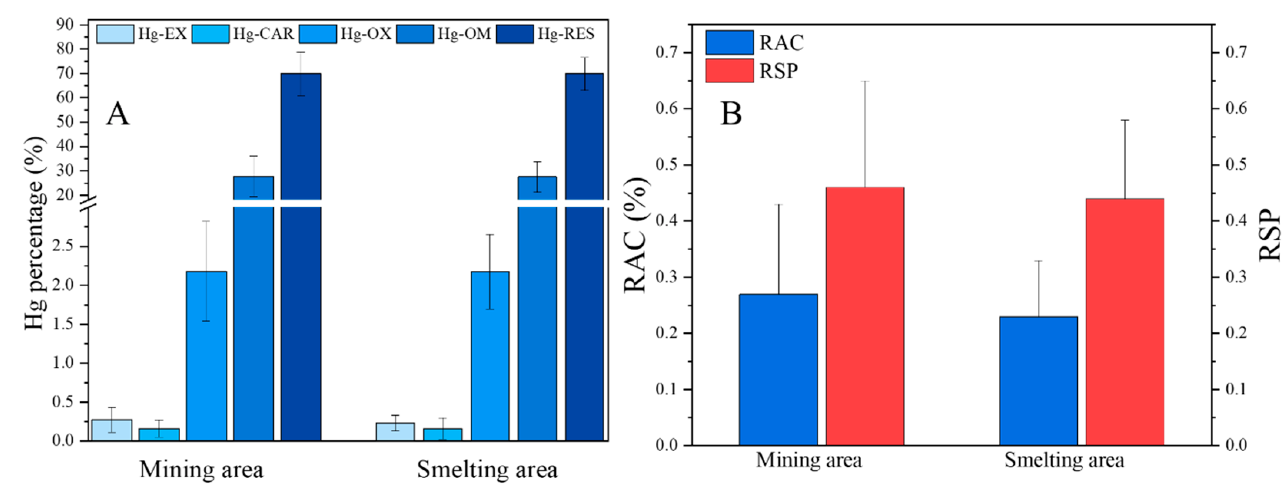
Figure 7. Geochemical fractionation of Hg in soil in the mining and smelting areas ( A ) and potential hazard of soil Hg based on RAC and RSP models ( B ).